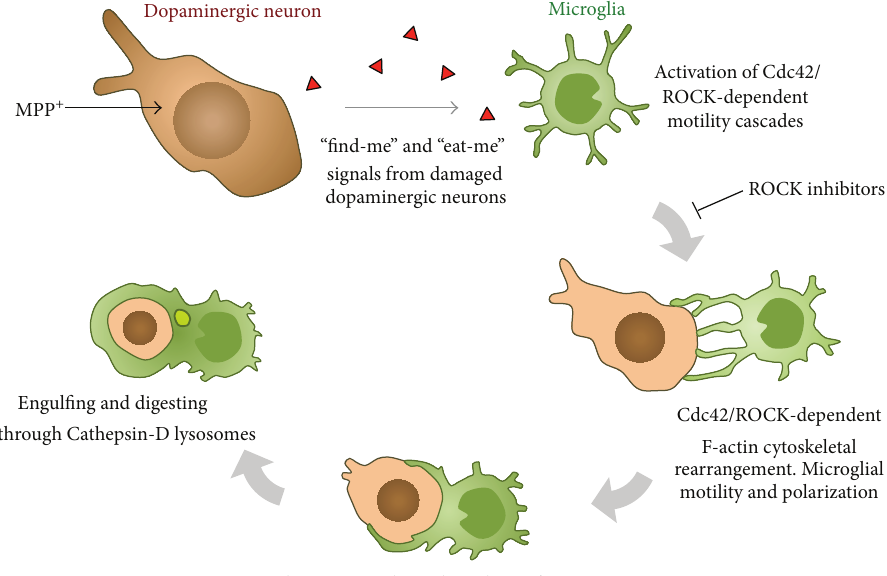
Figure 3: Graphical diagram of the motility and polarization of microglial cells in dopaminergic degeneration. Dopaminergic neuronal death generates the release of products, such as ATP or Ca 2+ , which activates the surrounding microglia. These gradients are able to attract microglia toward neurons (find-me signal). Cdc42/ROCK-dependent signaling controls the motility and polarization of microglia, which can be blocked by specific ROCK inhibitors. The motility of microglia starts with the polarization of microglial processes and then the apposition of the microglial cell body toward the neuron, forming an engulfing gliapse. In the engulfing process, dopaminergic neuron nucleus starts to show chromatin condensation and displays a pyknotic appearance. Cathepsin-D lysosomes digest the content of the phagosome (modified from